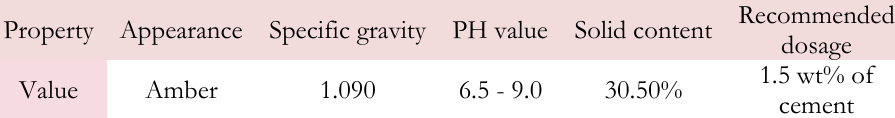
Table 2: Properties of super plasticizer [28]